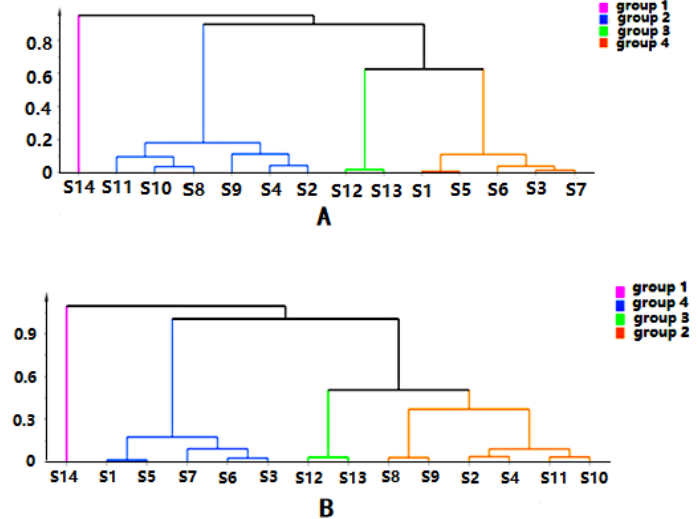
Figure 1. Hierarchical cluster analysis (HCA) of Cortex Periplocae from different producing areas, under the mode of positive ( A ) and negative ( B ) ions.